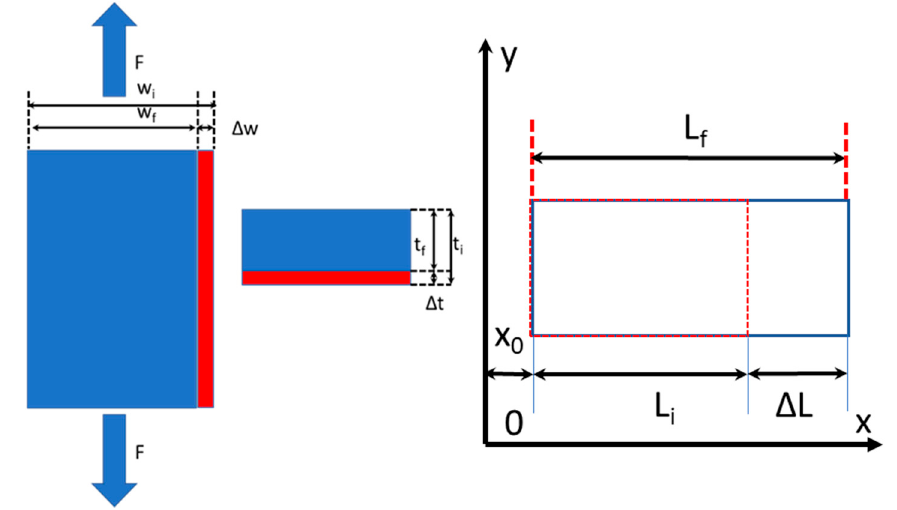
Figure 6. Tensile specimen subjected to uniform tensile stress, plane stress condition.